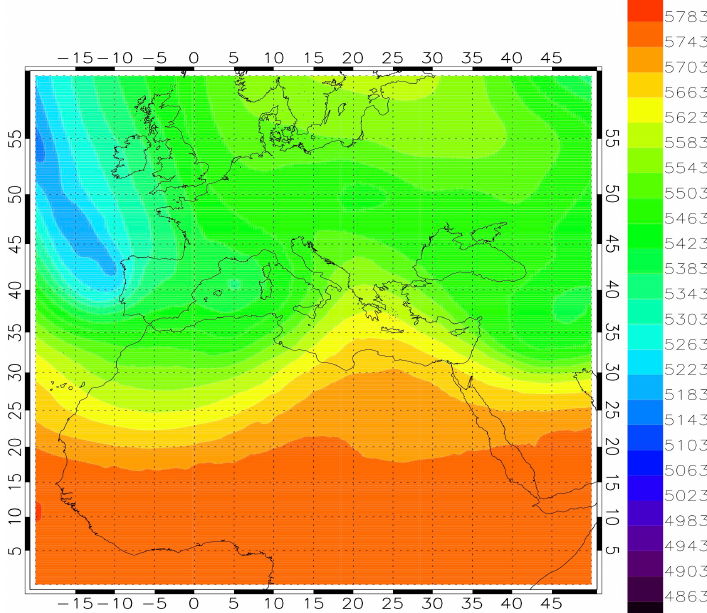
Figure 9. Geopotential height (m) at 500 hPa, at 00 UTC on 23 April 2019. The maps are generated using Copernicus Climate-Change Service Information